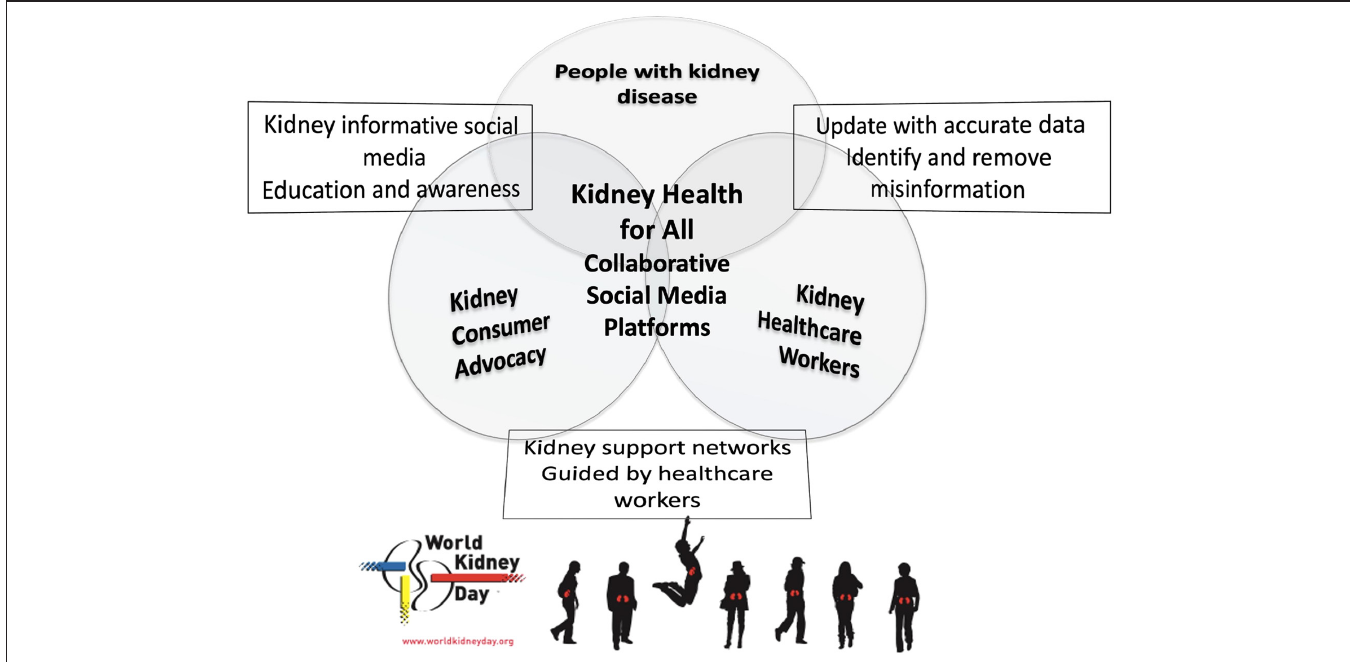
Figure 1. Schematic representation of consumer and health care professionals’ collaborative advocacy using social media platforms with the goal of Kidney Health for